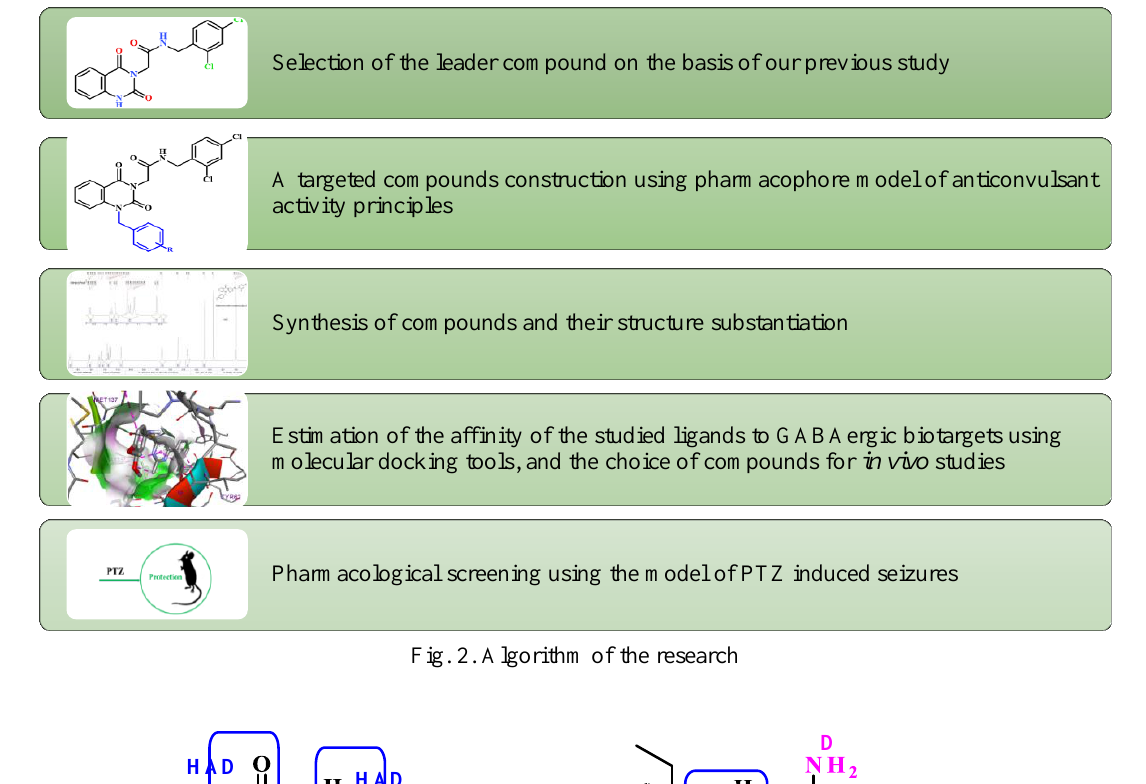
Fig. 2. Algorithm of the research